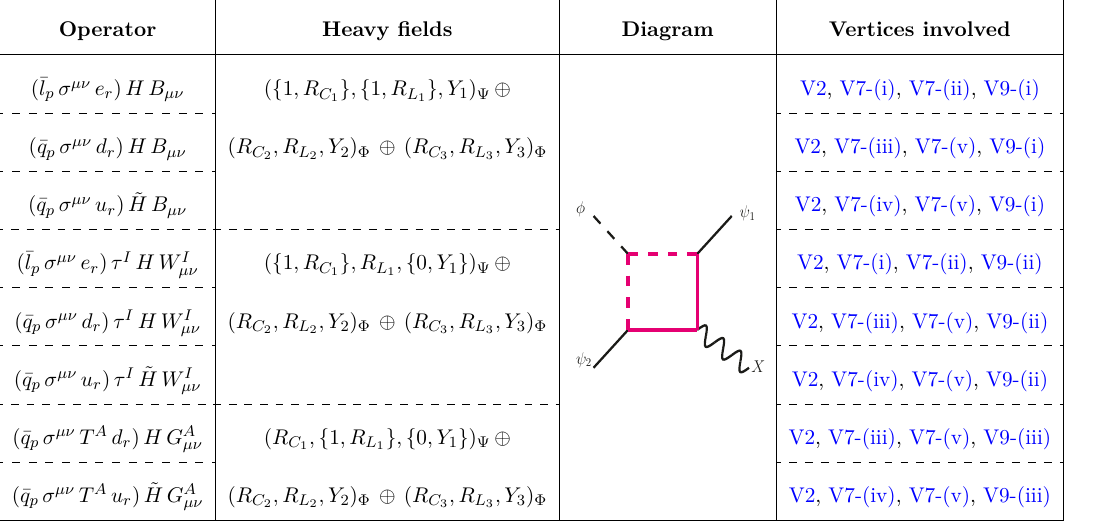
Table 21 . Combinations of heavy field representations that are required to unfold the ψ 2 φ X operators into non-trivial one-loop-level diagrams and the corresponding vertices for individual